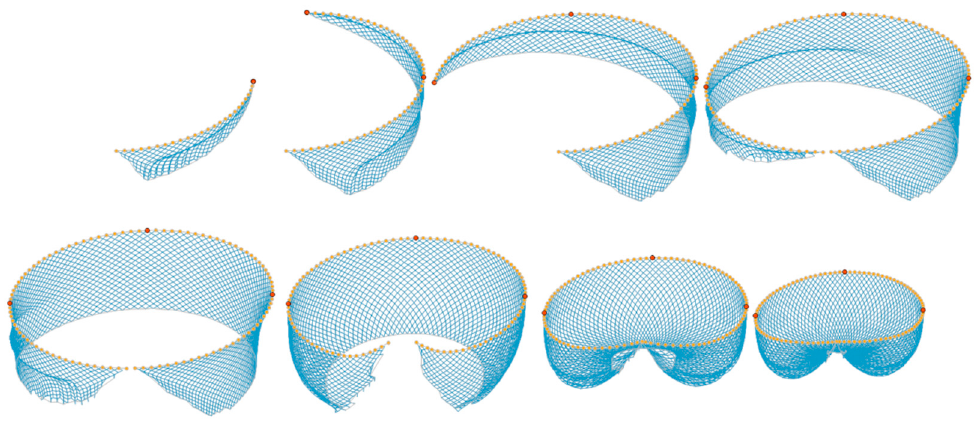
Figure 3. Snapshots from the sequential simulation of behavior of tuna purse seine from shooting to pursing in stationary water.